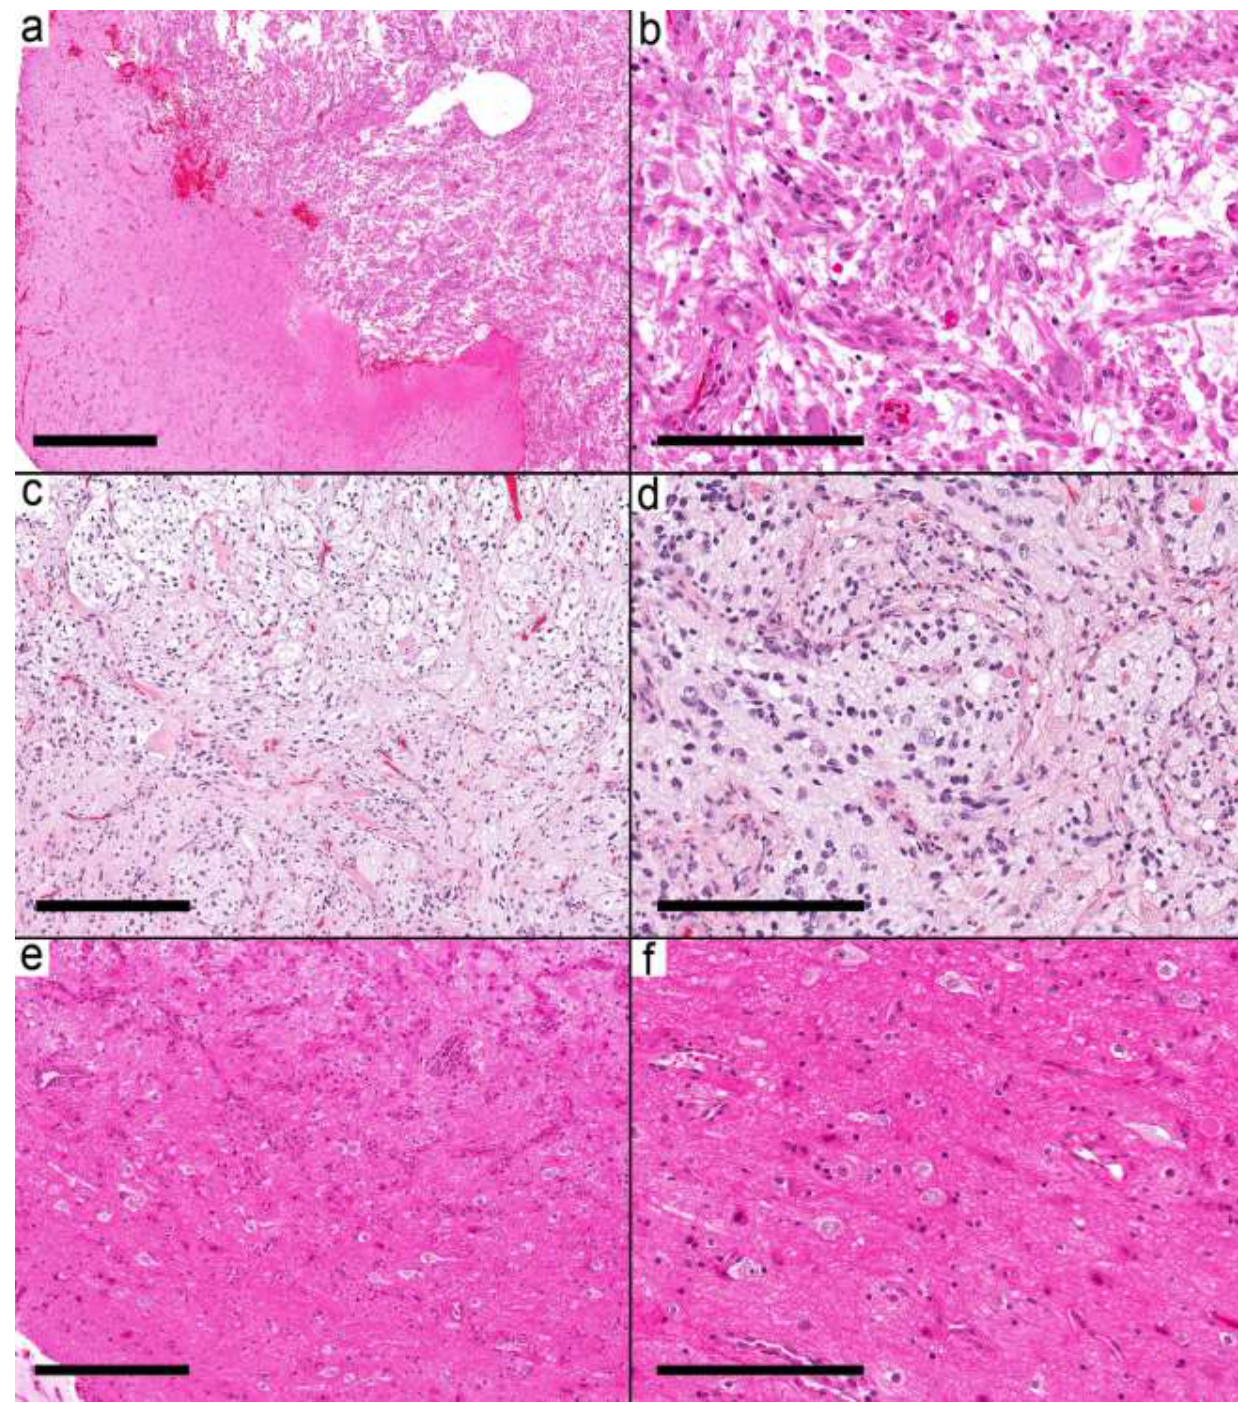
Figure 3. Ganglioglioma with circumscribed pattern. ( a ) Relatively demarcated nodular neoplasm (Case 14) on the right and gliotic brain tissue on the left side. ( b ) The nodule is formed by frequent dysmorphic ganglion cells and few glial cells. ( c ) Relatively demarcated nodule (Case 15) formed by biphasic tumor with microcystic spaces and fibrillary areas resembling pilocytic astrocytoma. ( d ) Frequent dysmorphic ganglion cells and background of the neuropil. ( e , f ) Relatively demarcated area (Case 17) with a moderate number of dysmorphic ganglion cells and a minor glial component in the background. Scale bars: 600 µm ( a ); 200 µm ( b , d , f ); 300 µm ( c , e ).